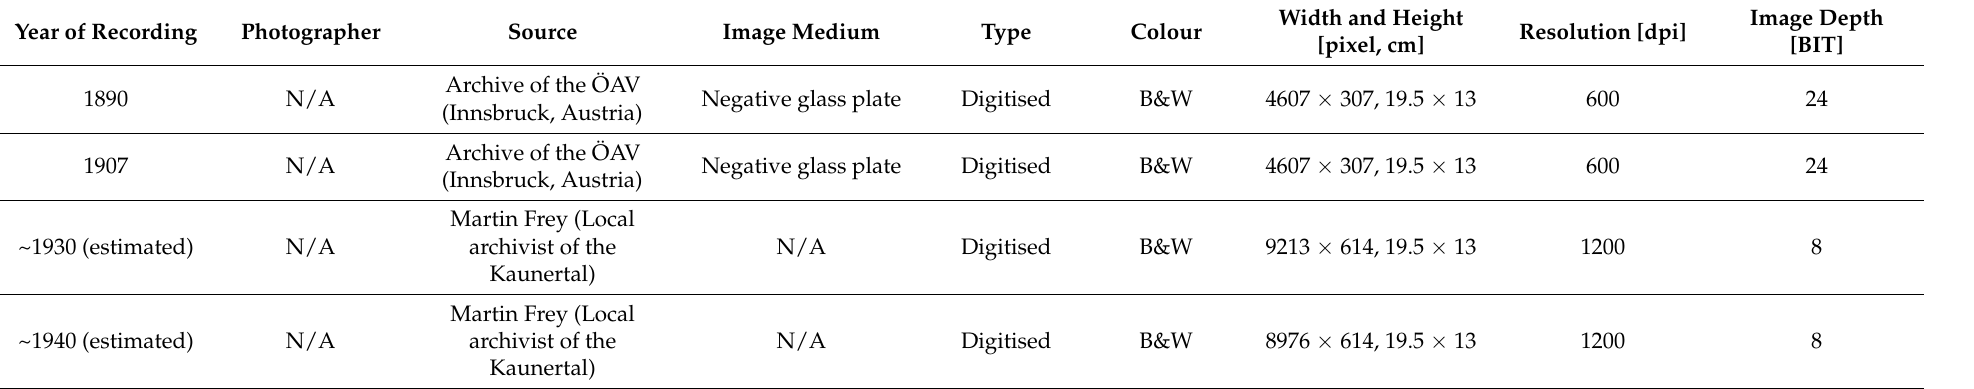
Table A2. Attributes of historical terrestrial oblique photos.